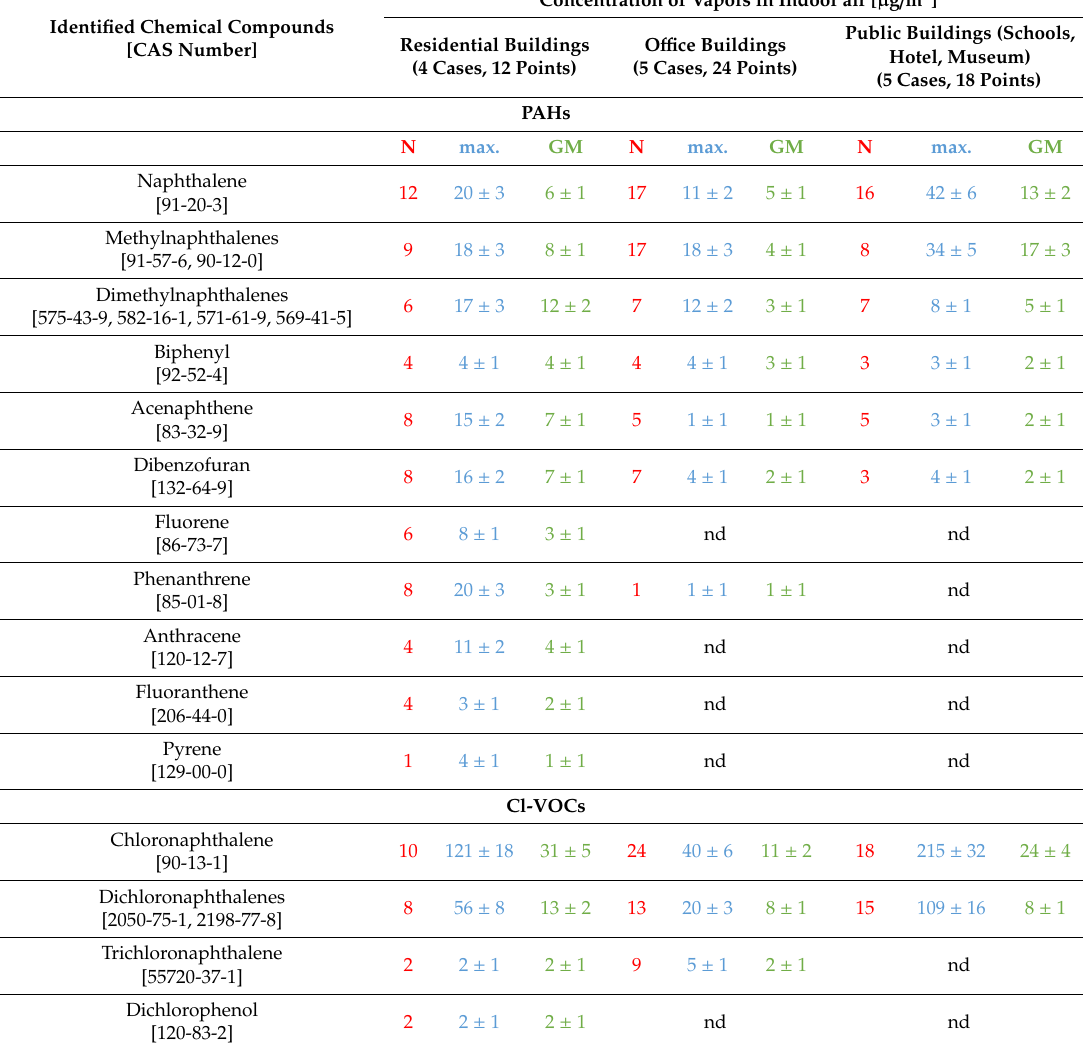
Table 3. Concentration of vapors of PAHs and Cl-VOCs in the indoor air of buildings where tar products and Xylamites were identified. The results were collated for 54 measuring points in 14 buildings, which were divided according to their purpose and